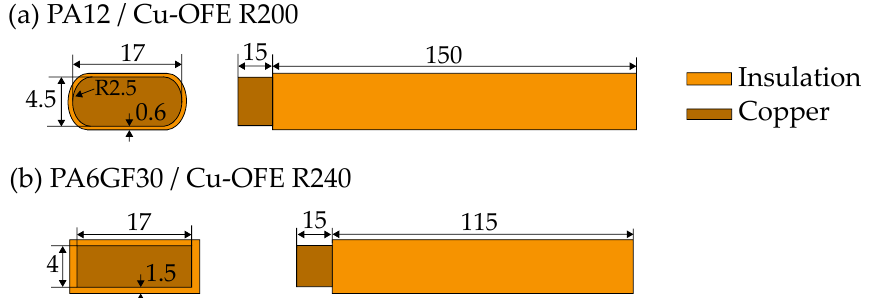
Figure 1. High-voltage busbar geometries (Unit: mm) used in this study: ( a ) PA12/Cu-OFE R200. ( b ) PA6GF30/Cu-OFE